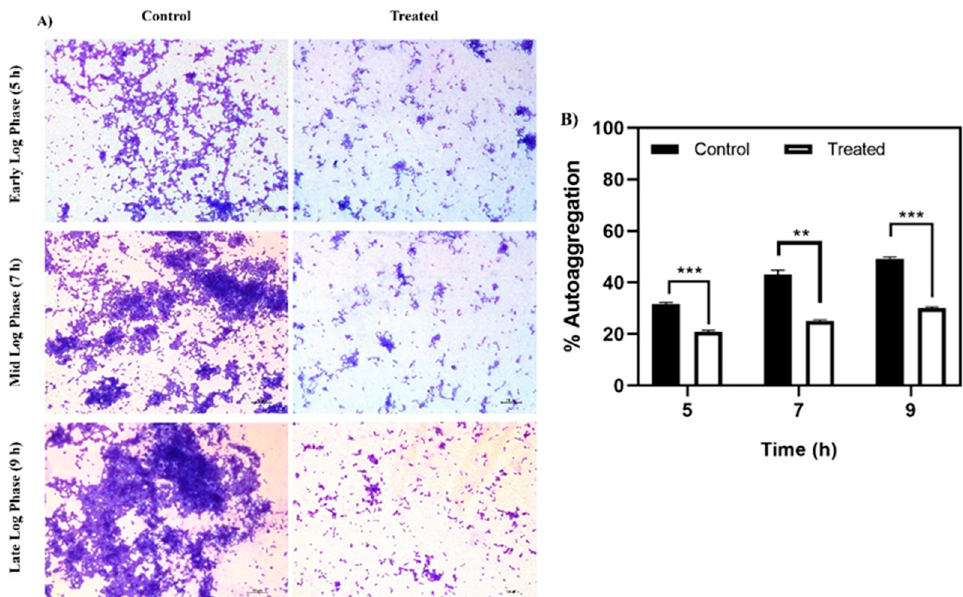
Figure 4. Effect of baicalein on autoaggregation. ( A ) Microscopic analysis of the reduction in autoaggregation for the baicalein treated cells in time dependent manner when compared to control. ( B ) Reduction in % autoaggregation. Student t-test was used for analysing significance and p < 0.05 was considered significant. * denotes p ≤ 0.05, ** denotes p ≤ 0.01 and *** denotes p ≤ 0.001.